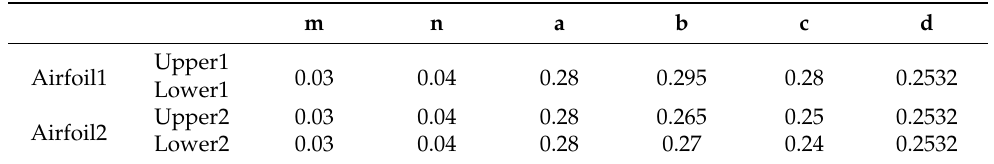
Table 2. Parameter values for generating new airfoil.